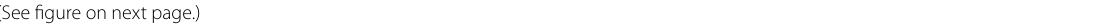
Fig. 1 Delica EMS 9D robotic TCD probe and headband. TCD transcranial Doppler. A TCD probe (black circular object) held with robotic drive as one construct within plastic casing. Medial view—where probe contacts patient for transtemporal insonation of the middle cerebral artery.